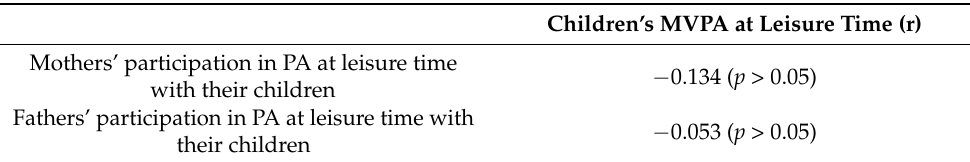
Table 4. Pearson correlations between preschool children’s MVPA and parents’ reported participa- tion in MVPA with their children.